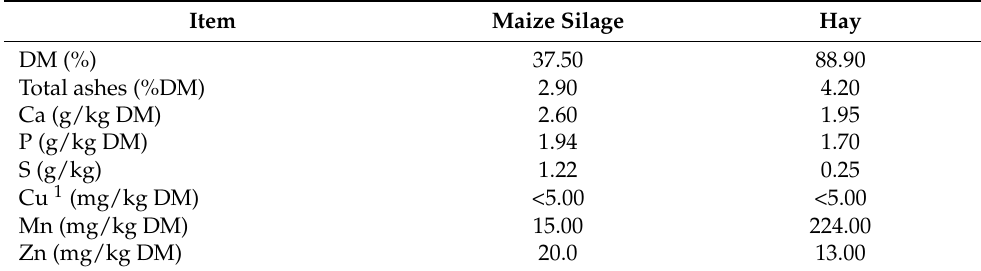
Table 1. Mineral content in substrates used for the in vitro fermentations.